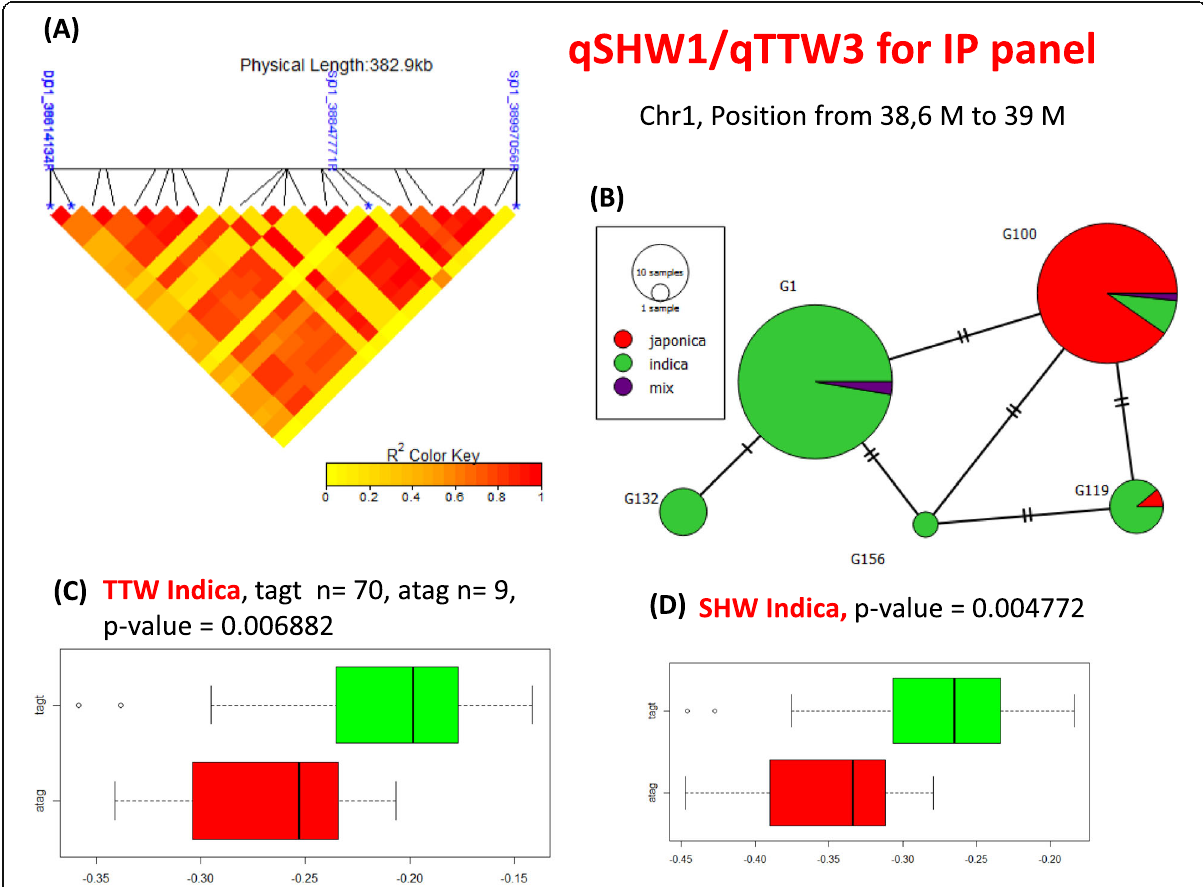
Fig. 7 Haplotype analysis for qSHW1/qTTW3 a Linkage Disequilibrium heatmap in the peak region of association analysis GWAS for qSHW1/TTW3. Significant SNP indicated as blue star in the photo and the pattern pairwise r 2 of the associated SNPs in the QTL indicated with color code. Red color means SNPs are strongly associated to each other and yellow color means no association. The Linkage Disequilibrium heat map was created using the “ LDheatmap ” package in R b Population architecture of accessions based on the allelic combination significant SNPs in each QTL. Population architecture image is created by PopArt1.7 software. c and d Effect of allelic combination of 2 main haplotypes of each QTL on the value of interested traits. Number of accessions for each haplotype is indicated as (n). Welch Two Sample t-test was used to assess the differences between two haplotypes. *, **, *** indicated significant difference at p value < 0.05, 0.01 and 0.001